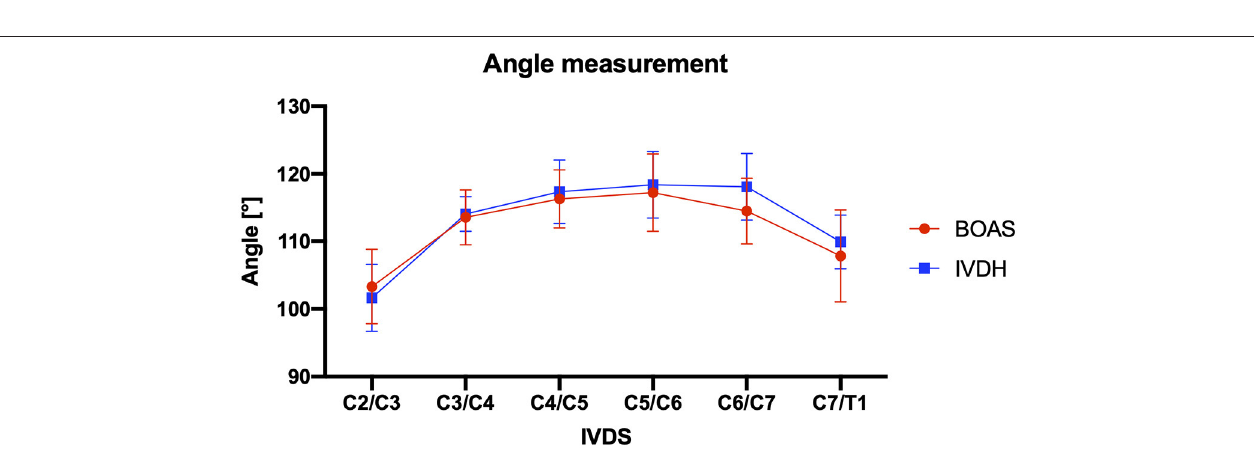
levels of C5/C6 ( P = 0.0092) and C6/C7 ( P = 0.0076). A